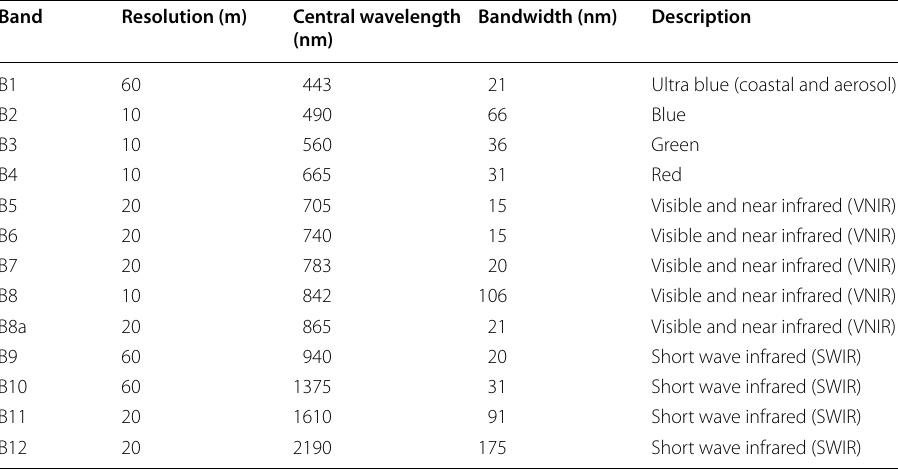
Table 1 Sentinel-2 bands and their spatial and radiometric resolutions Band